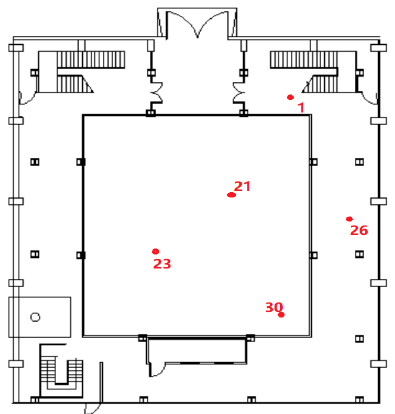
Figure 11. Distribution map of test feature points on the first floor.